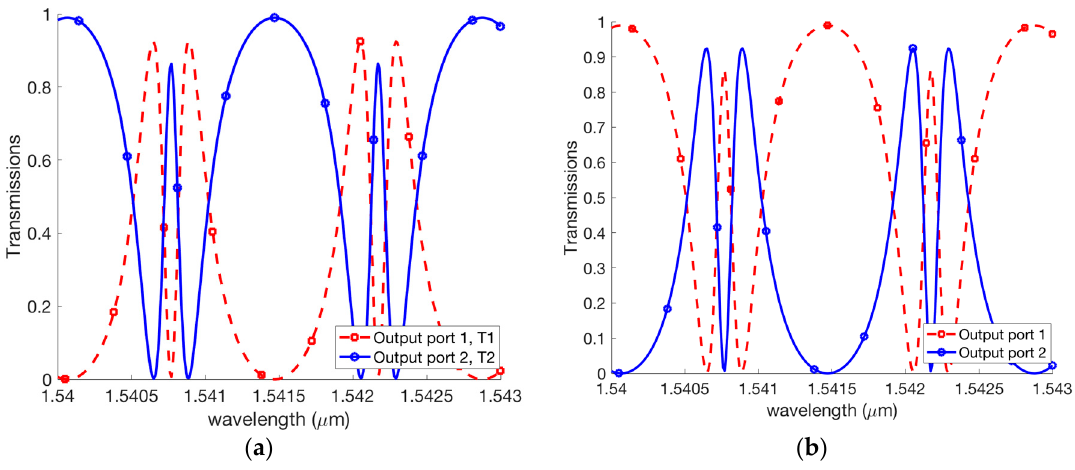
Figure 6. Transmissions of the coupled Fano resonances for Figure 5a with input signal is presented at ( a ) input port 1 and ( b ) input port 2.